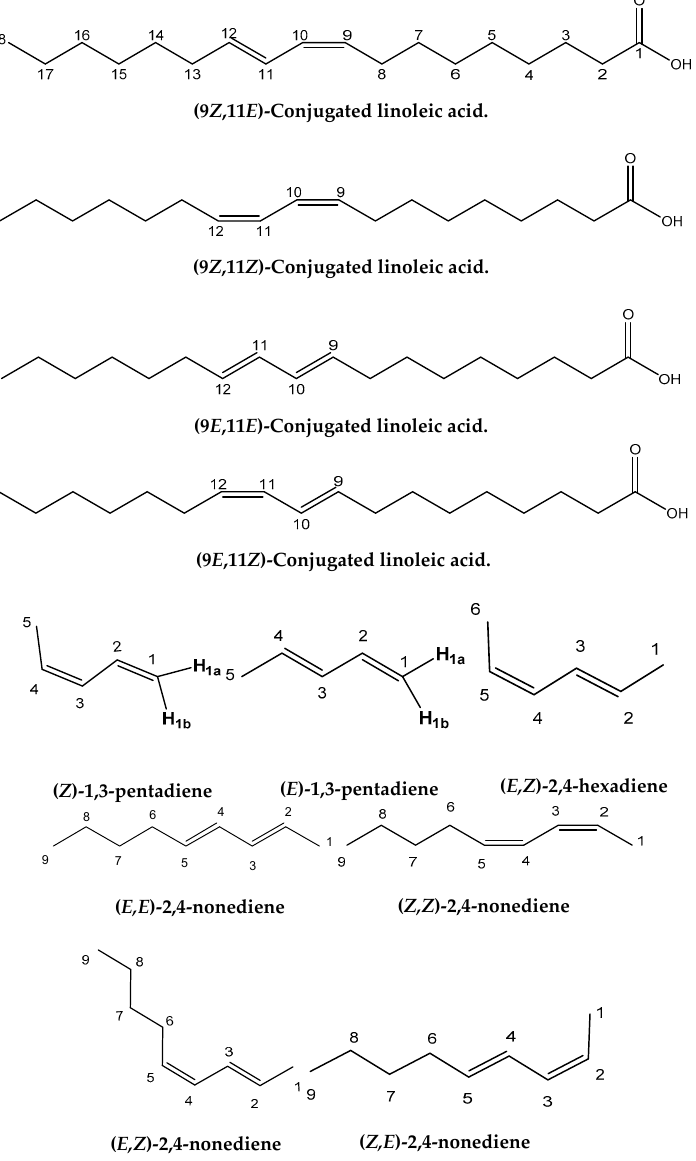
Figure 1. Chemical structures of the four geometric isomers of the 18:2 ω -7 conjugated linoleic acid (rumenic acid) and the model compounds investigated in the present work.